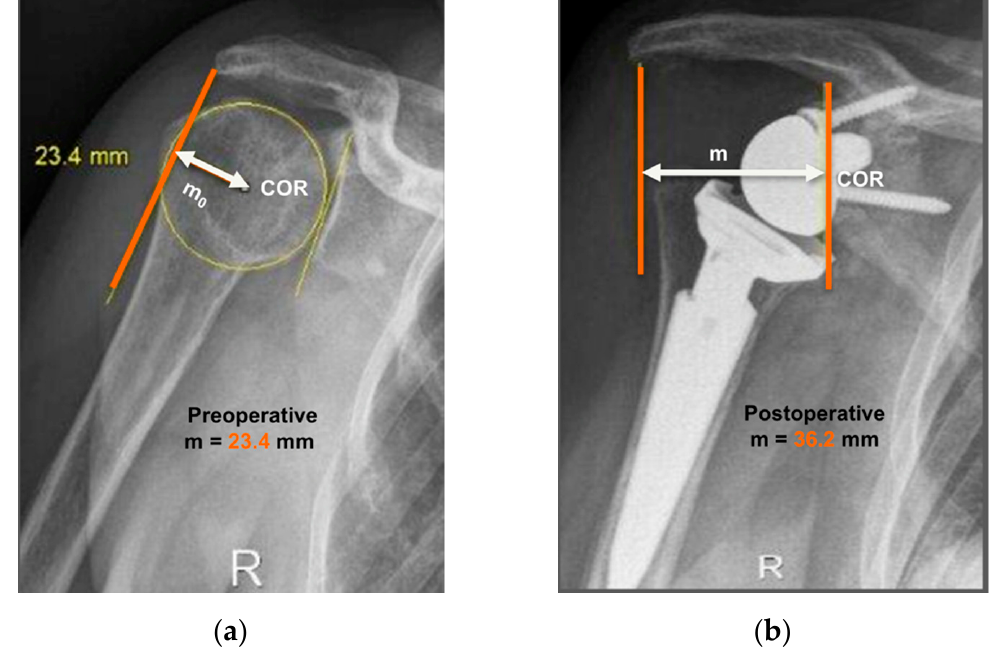
Figure 1. Anteroposterior radiographs of the same patient pre- and post-operatively are shown. Evaluation of center-of-rotation (COR) medialization was performed according to the protocol of Greiner et al. [5]. Pre-operatively ( a ), the distance “m o ” was measured between the center of the circle involving the articular surface (COR) and the vertical line from the outer border of the acromion. Post-operatively ( b ), the distance “m” was measured between the center of the base plate (COR) and the vertical line from the outer border of the acromion. COR medialization was calculated as the di ff erence between the distances “m o ” and “m” as follows: ∆ m = m o − m. m o > m was found in all subjects (12.8 mm for this representative patient).